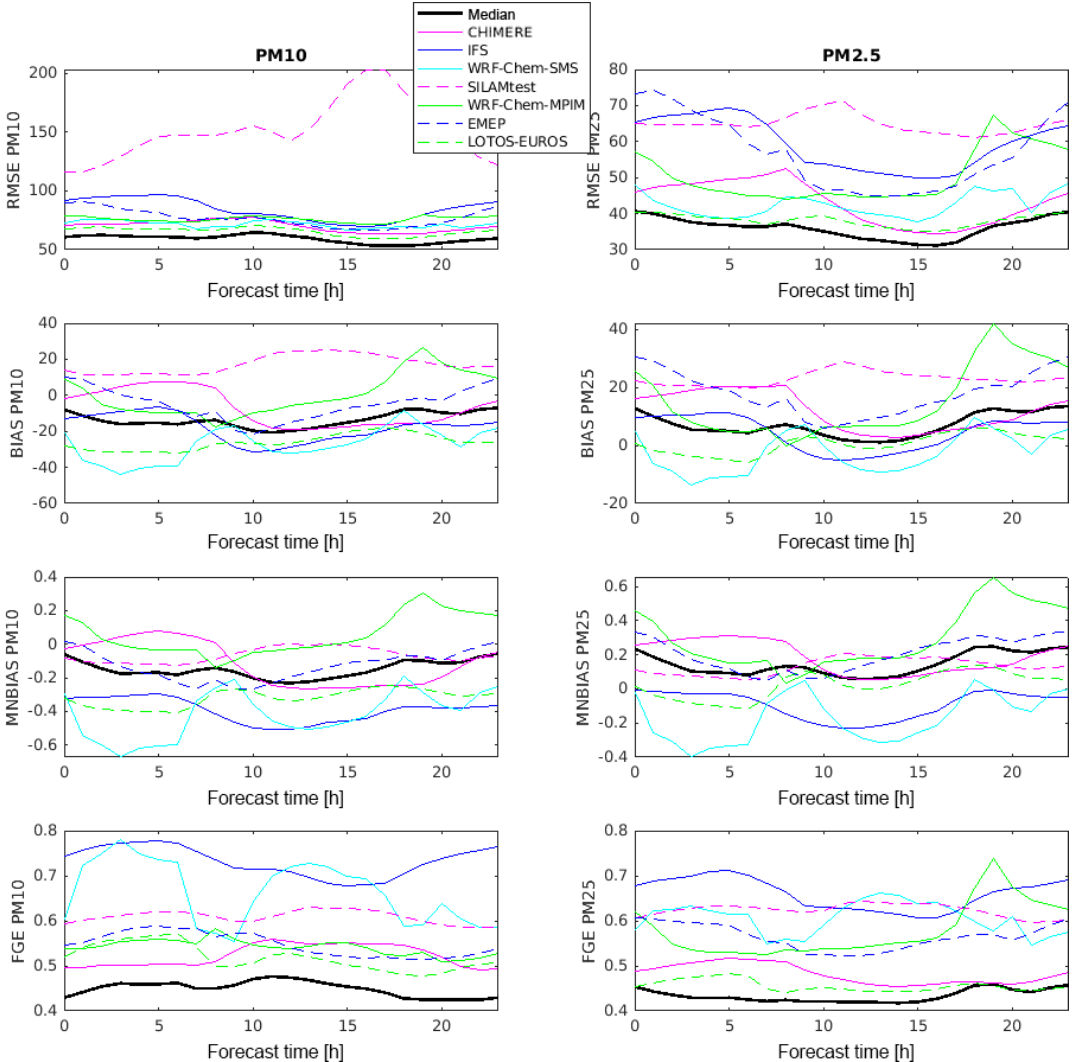
Figure 7. RMSE, BIAS, MNBIAS, and FGE of PM 10 and PM 2 . 5 over the forecasting time (time of the